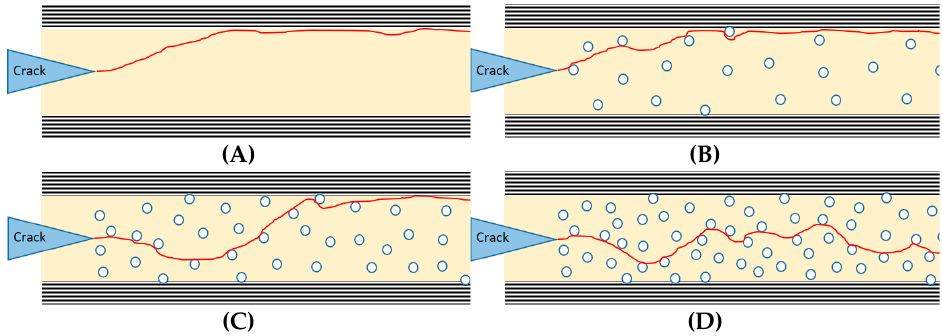
Figure 5. Crack propagation in the ( A ) reference, ( B ) PSF-I, ( C ) PSF-II, and ( D ) PSF-III.